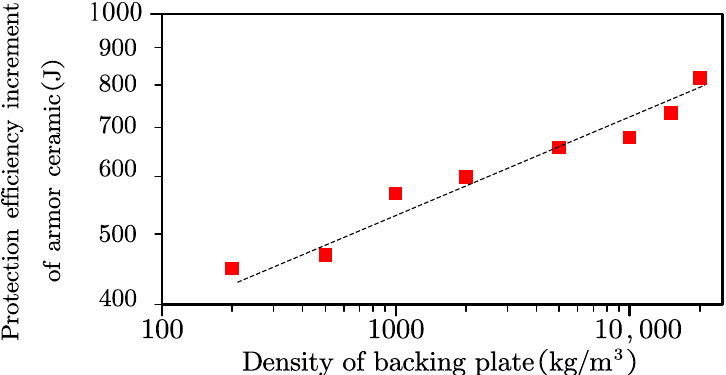
Figure 8. Double logarithmic coordinates describing the protection efficiency increment of the armor ceramic and density of the backing plate.